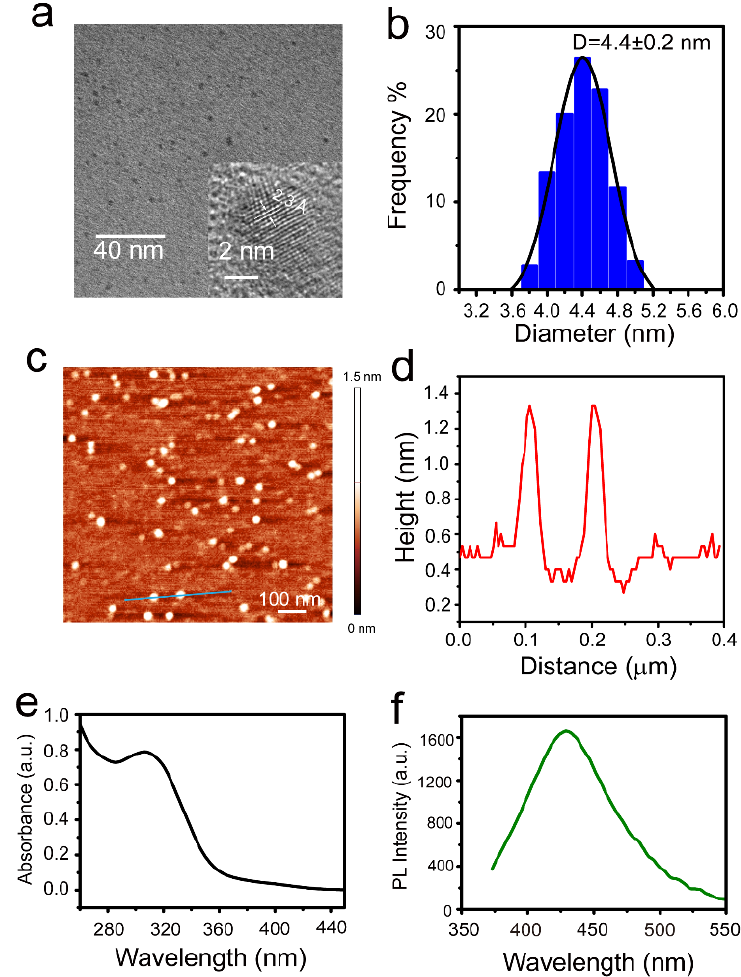
Figure 1. ( a ) TEM image of monodispersed MoS 2 QDs, and the inset shows the HRTEM image with lattice spacing; ( b ) diameter distribution histogram of MoS 2 QDs; ( c ) AFM image of MoS 2 QDs; ( d ) corresponding height profile of blue line labeled in ( c ); ( e ) UV–vis absorption; ( f ) photolumines- cence spectra of MoS 2 QDs.